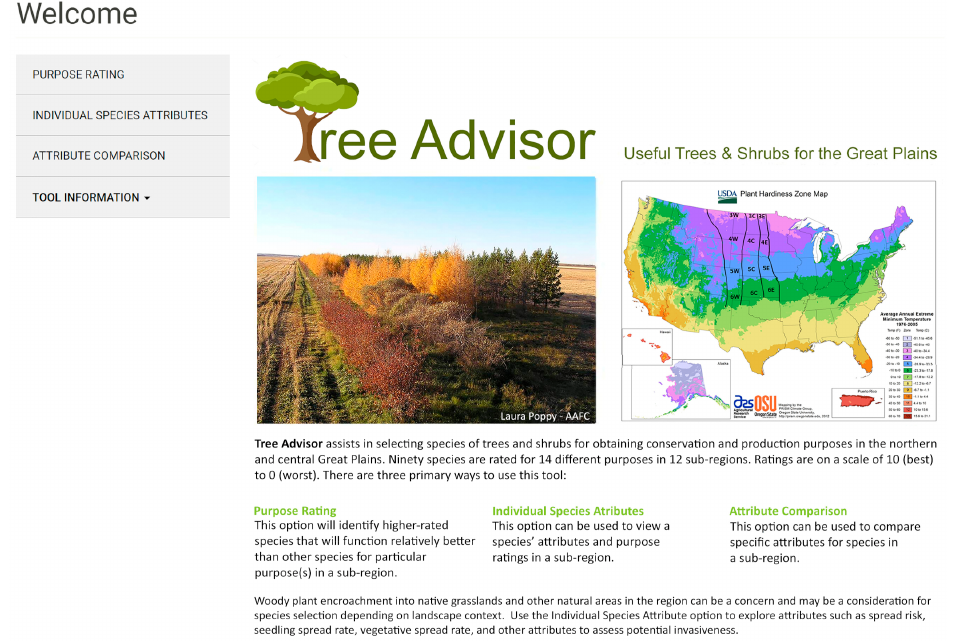
Figure 3. The home page for Tree Advisor provides users with three options for using the DST.